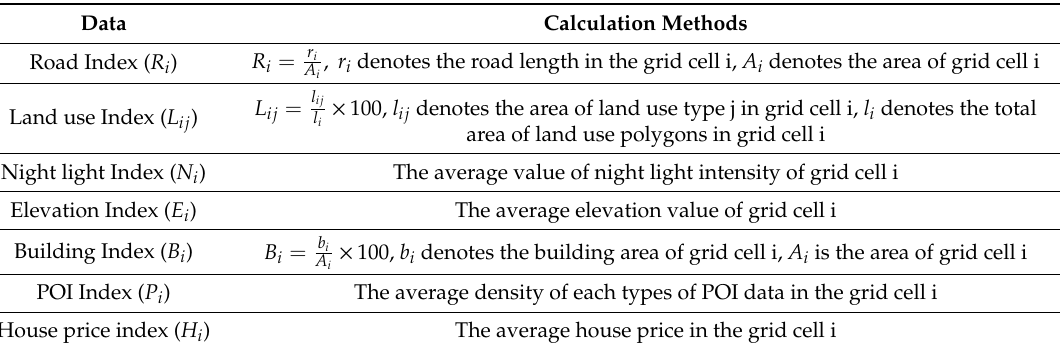
Table 2. Data Source